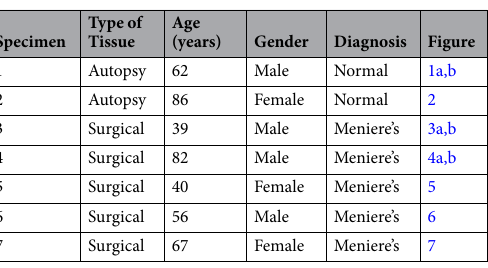
Table 1. Specimens (utricle) used in the present study. Autopsy: Temporal bones collected between 6 to 8 hrs. postmortem, Normal: indicates normal vestibular and auditory